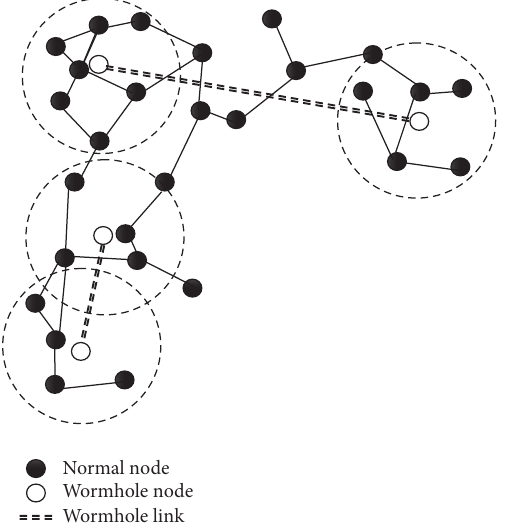
Figure 1: Wormhole attack